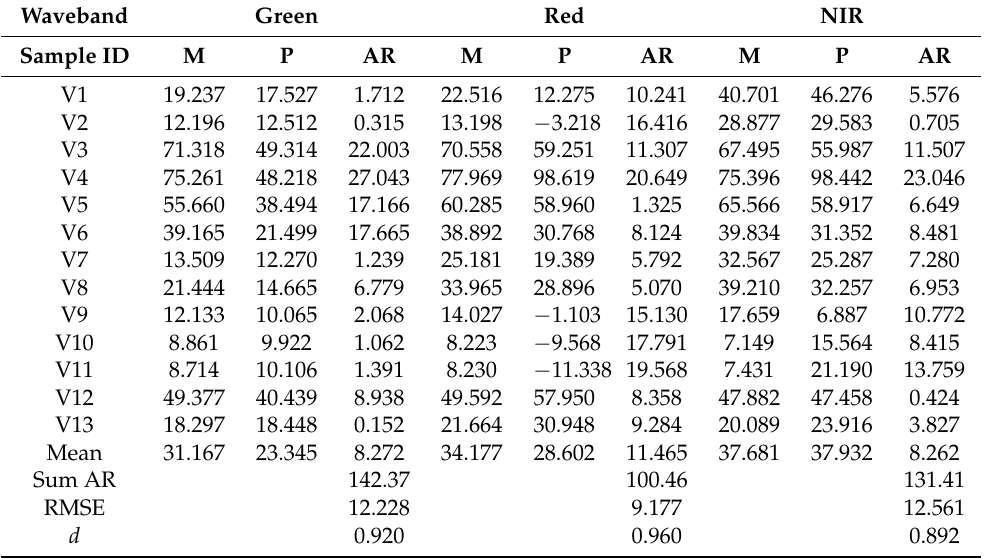
Table 17. Measured (M) and EL2-predicted (P) mean spectral reflectance (%) of 13 validation samples using EL1 Spectralon intercept. Waveband Green Red